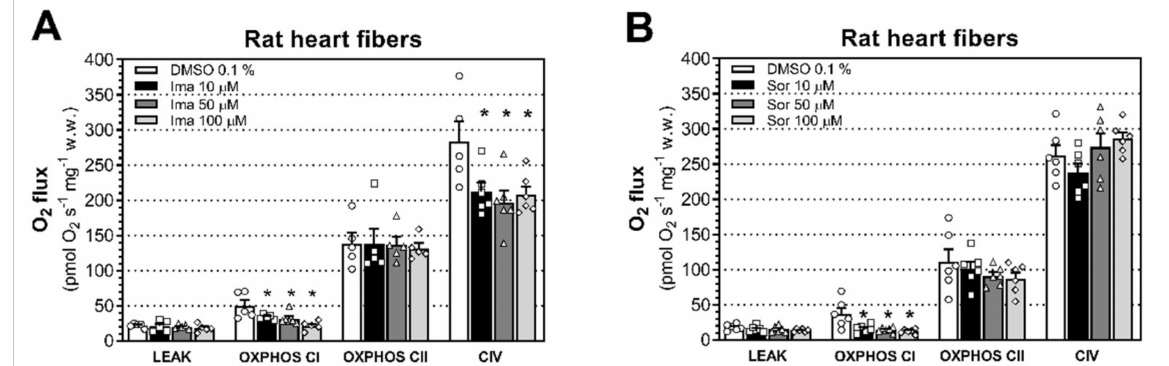
Figure 3. Effects of acute exposure of imatinib and sorafenib on mitochondrial respiratory capacities. We exposed permeabilized cardiac fibers from rats to imatinib ( A ) and sorafenib ( B ) for 15 min and then measured respiratory capacities through complexes of the ETS in the presence of the drugs or DMSO 0.1%. Data represent the mean ± SEM of at least five independent experiments. * P < 0.05 versus 0.1% DMSO